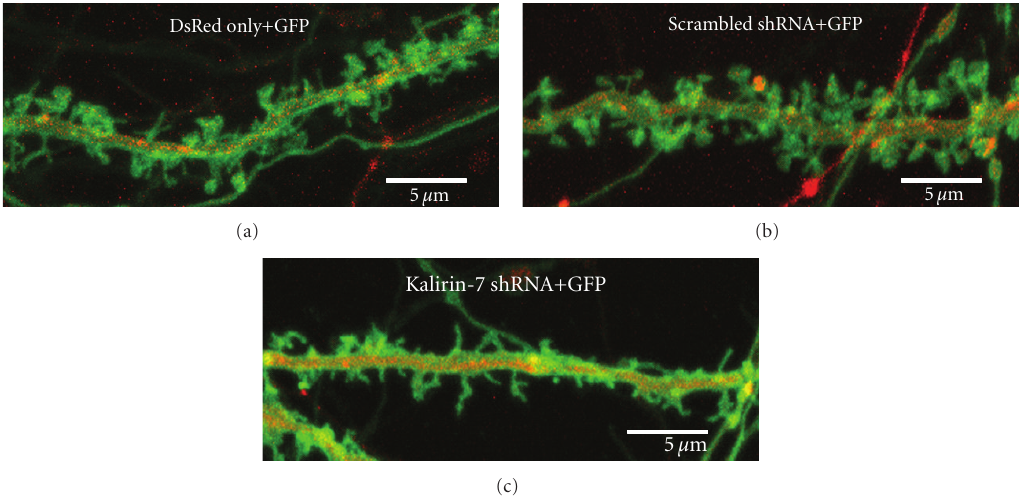
Figure 3: Expression of Kalirin-7 shRNA causes a reduction in spine density and spine size in cultured hippocampal neurons. Cultured hippocampal neurons prepared at E20 were transfected with vector encoding a membrane-tethered version of GFP (pmGFP) alone [(a), spine density 8.9 ± 0.8/10 μ m], pmGFP plus a scrambled shRNA [(b), spine density 9.2 ± 0.9/10 μ m], or pmGFP plus